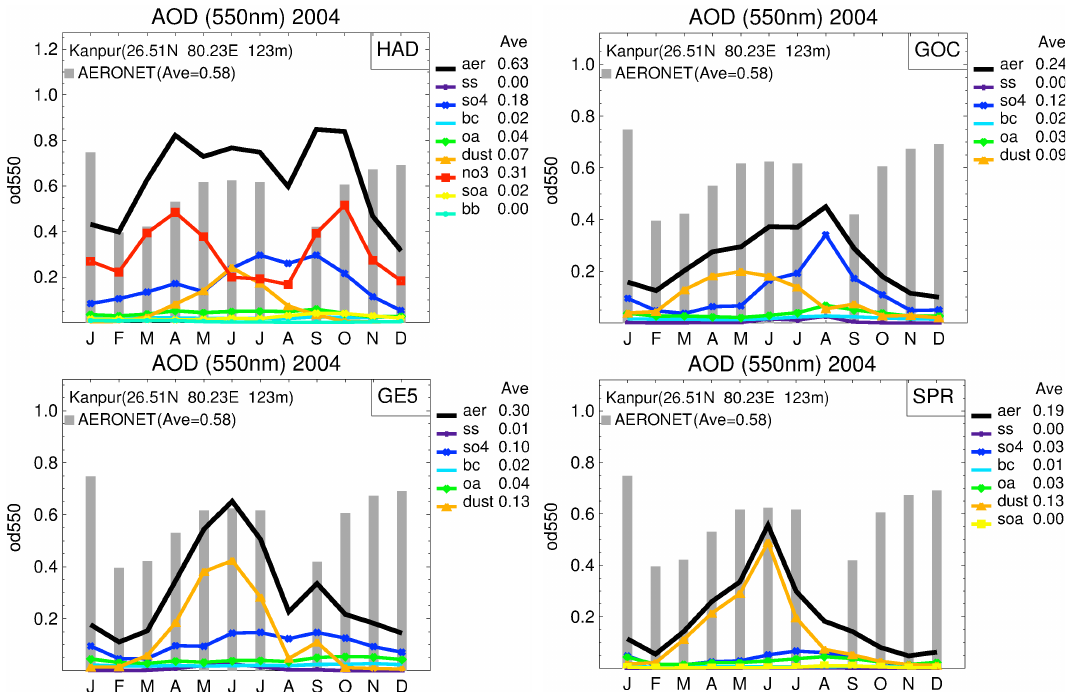
Figure 6. Monthly-mean AOD of total aerosol (aer) and components (ss, so 4 , bc, oa, dust, no 3 , soa and bb) at Kanpur in 2004 from four models, HAD (upper left), GOC (upper right), GE5 (lower left), and SPR (lower right). The gray bar represents total AOD from AERONET, and the lines represent the model results of total AOD (black line) and component AODs (colored lines). The corresponding annual mean values are also listed. Note: For the HAD model, bc and oa are only from fossil fuel sources; the biomass burning aerosol is labeled